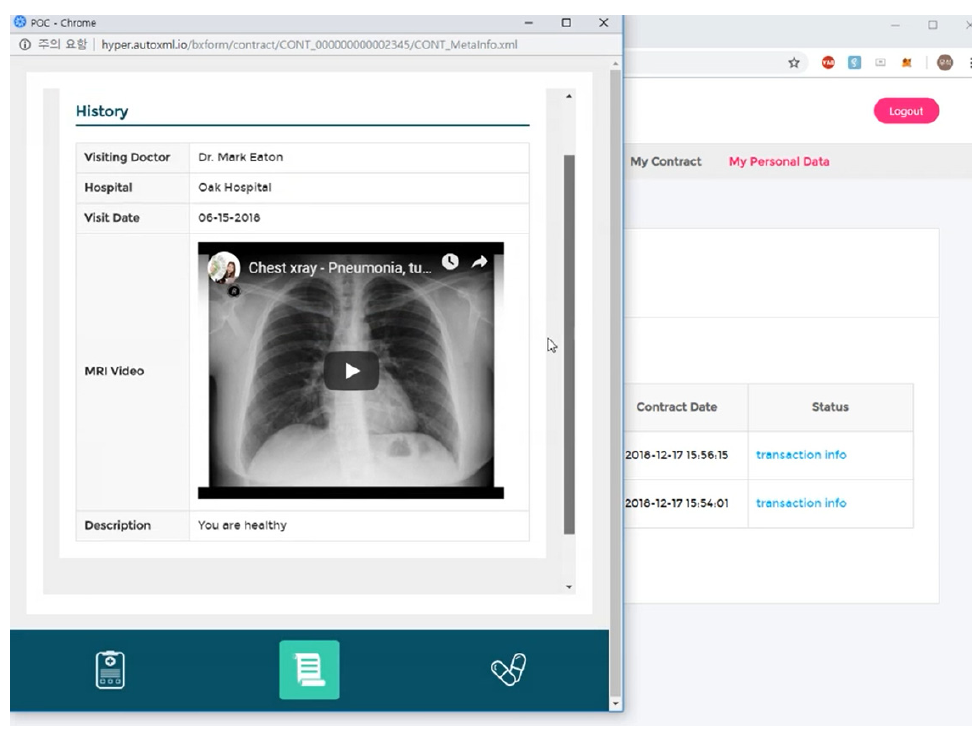
Figure 16. Blockchain PHR privacy screen using the neural network.